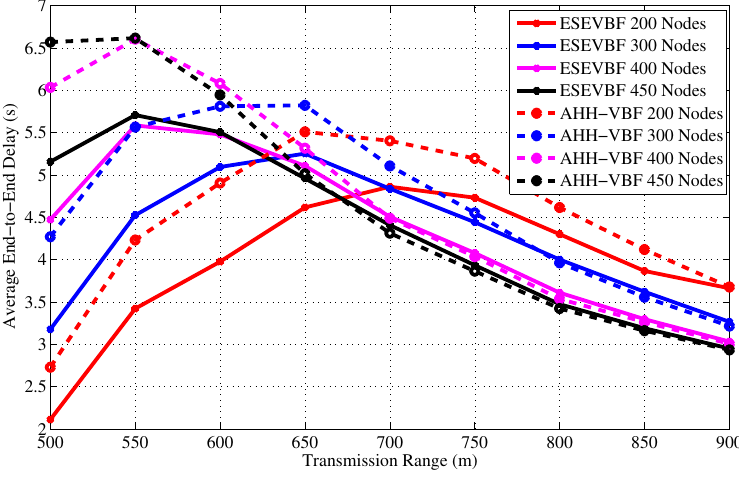
Figure 9. End-to-End delay between the source node that generated data message and Sink node versus transmission